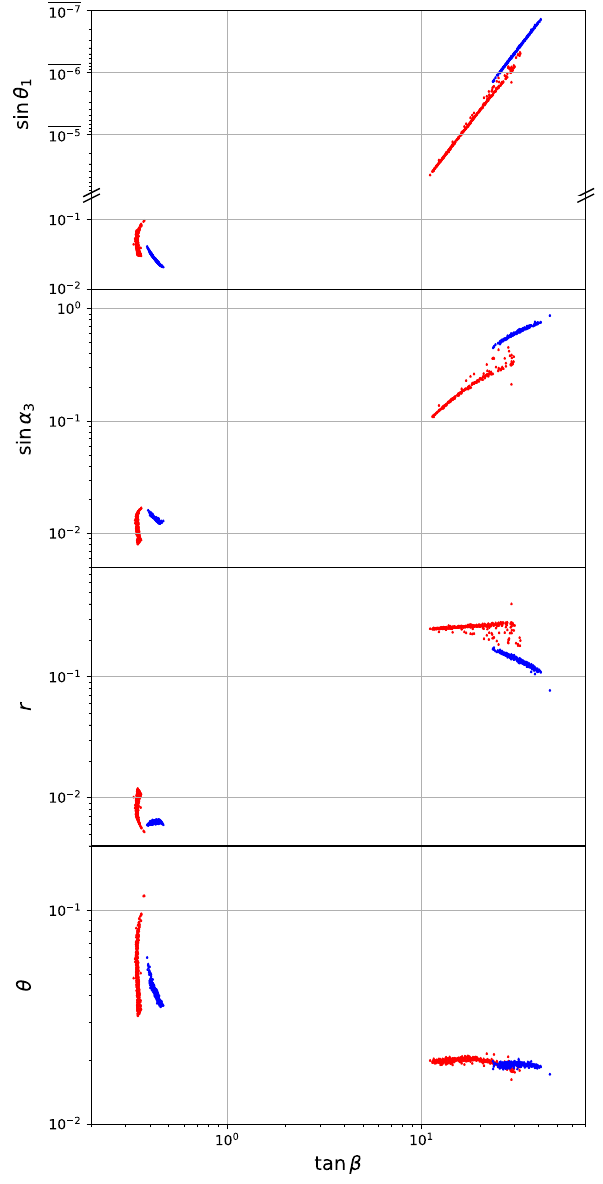
Fig. 2 Parameterspaceconsistentwithneutrinooscillationparameters at 2 σ level and cosmology constraint on neutrino mass eV. The parameter space is projected onto the sin (θ 3 ) vs sin (α 1 ) , tan β , r and θ plane (from top to bottom respectively. Blue and red points correspond to IO neutrino masses. For red points, θ 23 resides in the first octant. X = 1 − X